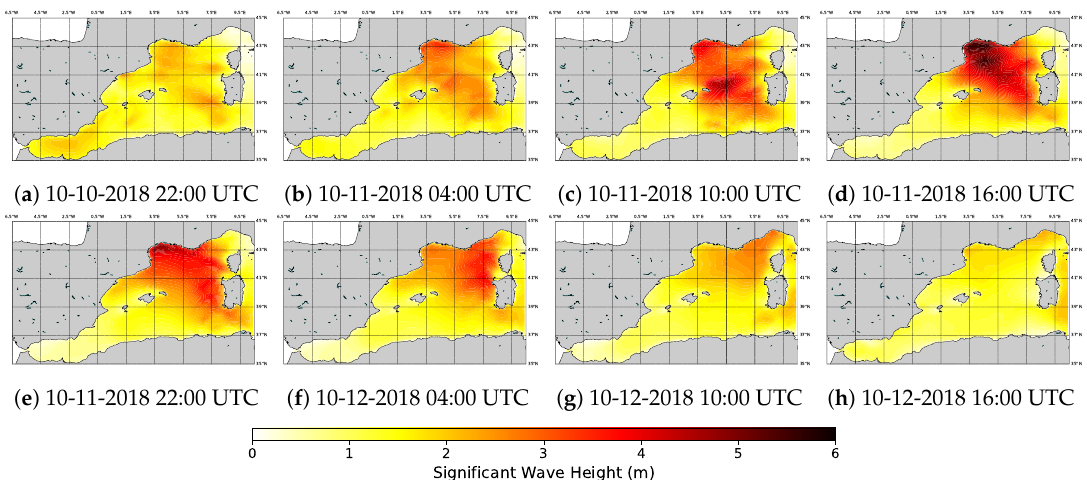
Figure 4. Evolution of the significant wave height ( H S ) in the AOI, with snapshots (Figures 14.a–14.h) every 6 h in the selected temporal window (10 October 2018 22:00 UTC–12 October 2018 16:00 UTC).